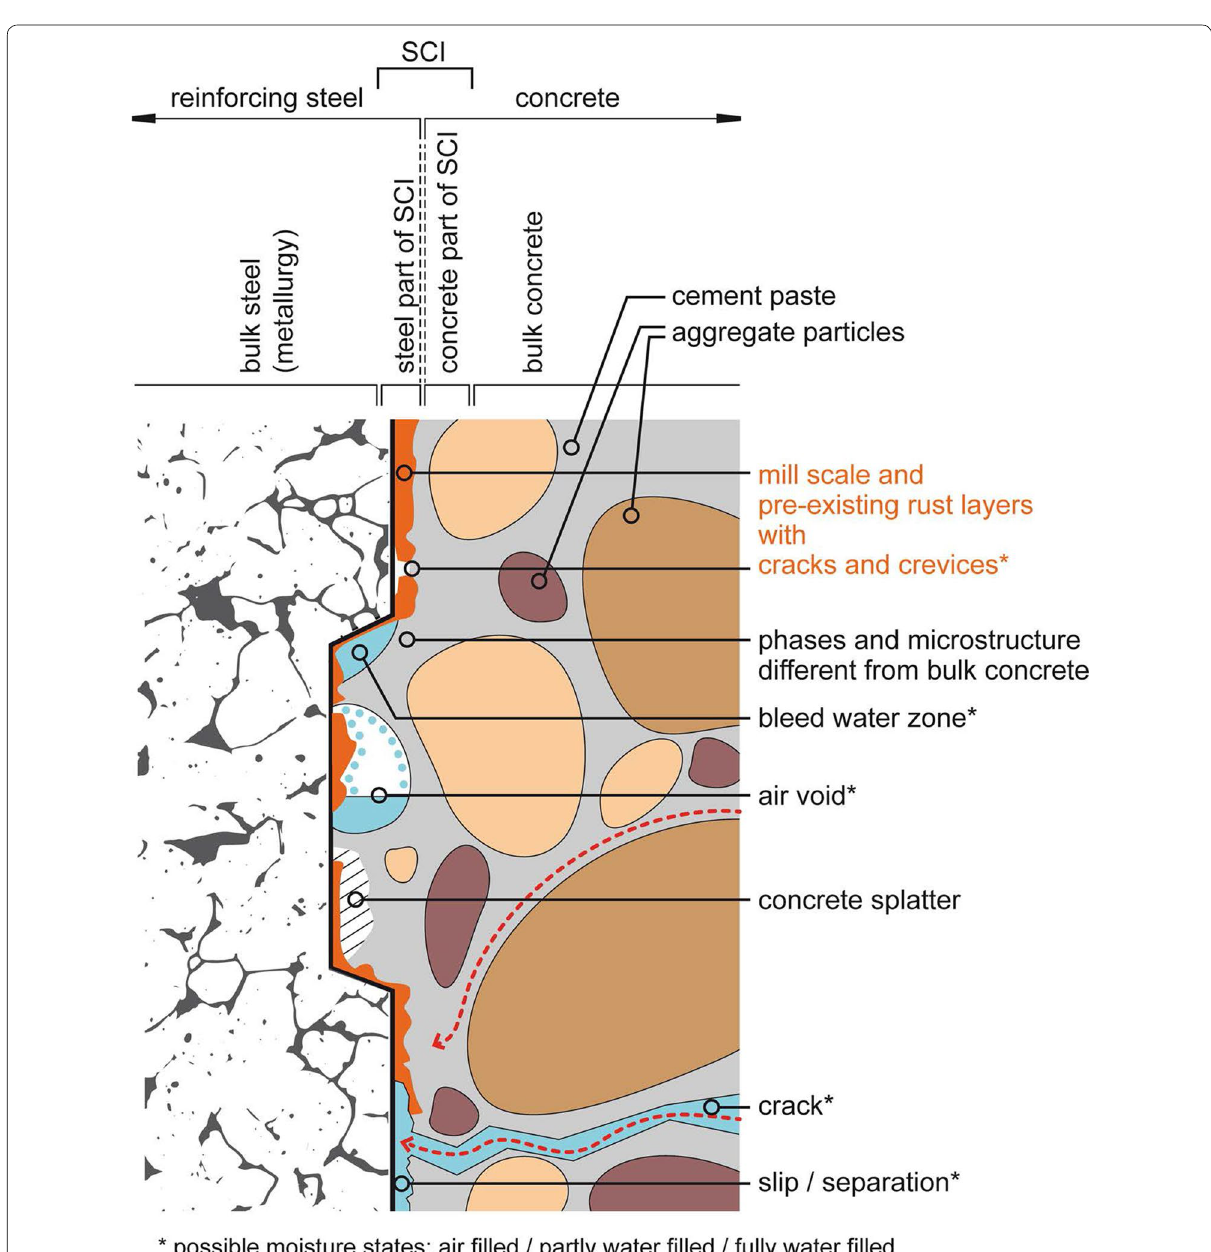
Fig. 1 Schematic illustration of selected randomly occurring characteristics at the Steel–Concrete Interface (SCI) that may or may not be present locally. Red dashed lines indicate preferential pathways for chloride ingress; blue dots represent adsorbed water (only shown for large pores). Water in cement paste is not shown. Figure reused from Angst et al. (2017), see